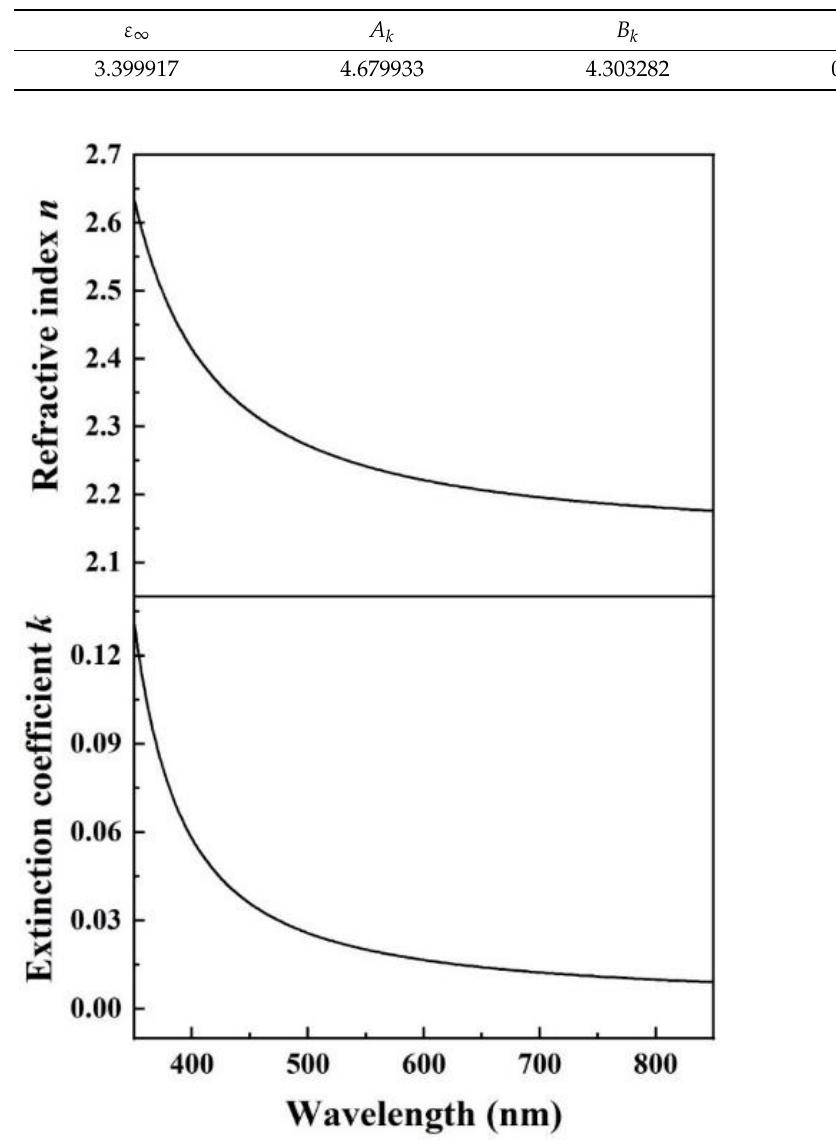
Figure 7. Refractive index n and extinction coefficient k of KTN thin film on SrTiO 3 substrate as a function of wavelength.